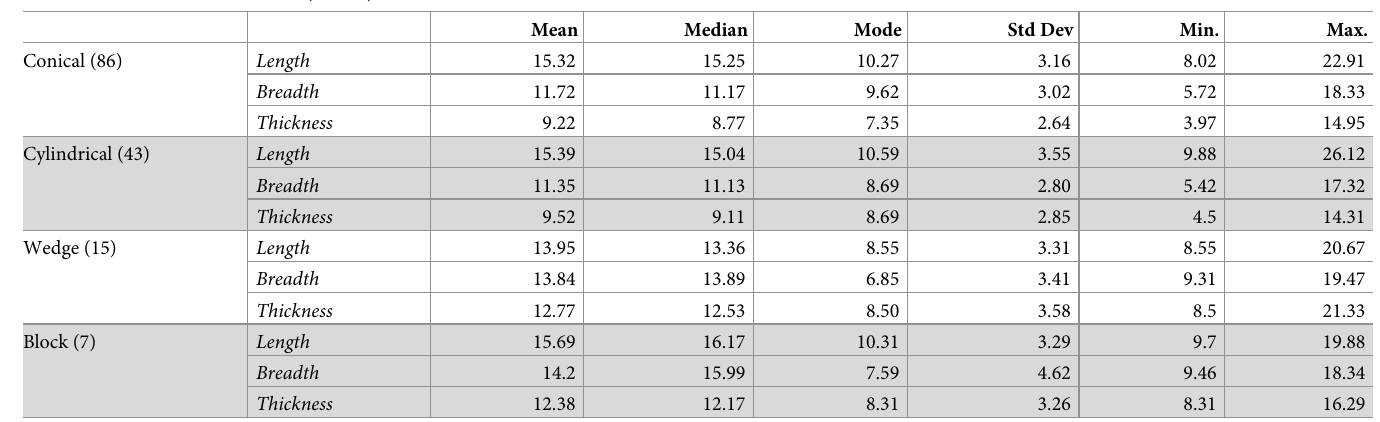
Table 3. Summarised metric data (in mm) of the blade cores from Vaharvo